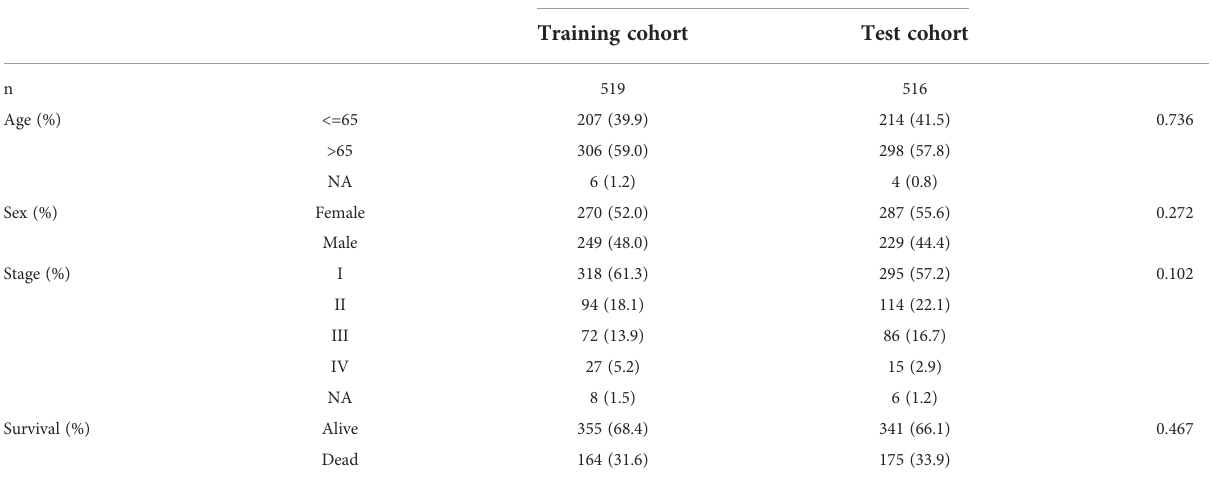
TABLE 2 Clinical characteristics of patients with LUAD in different